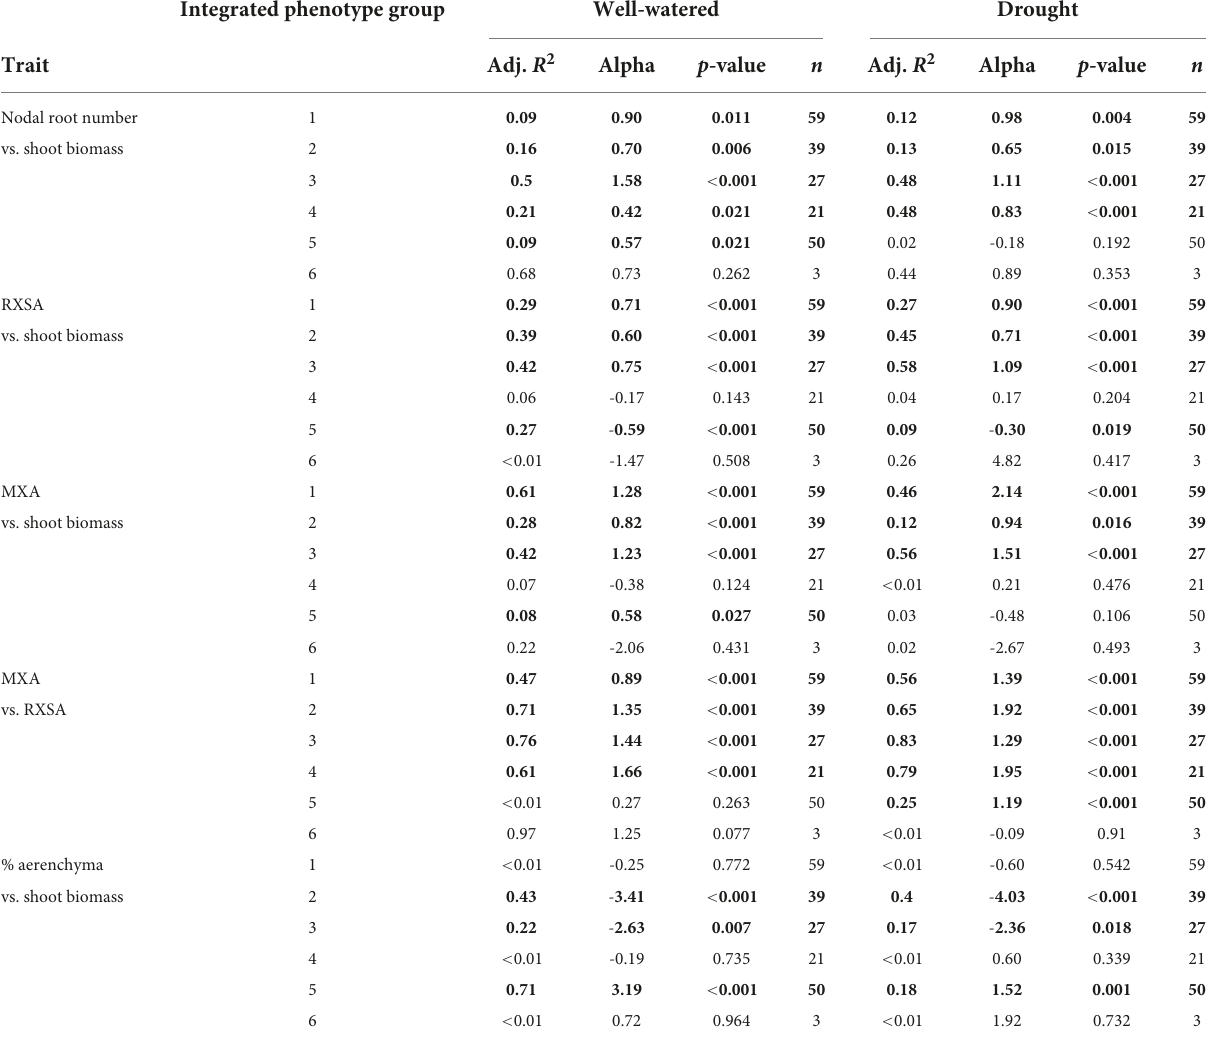
TABLE 3 Allometric partitioning coefficients (alpha) describing the slope of the natural logarithm of root traits vs. the natural logarithm of shoot dry biomass or root cross-sectional area. Integrated phenotype